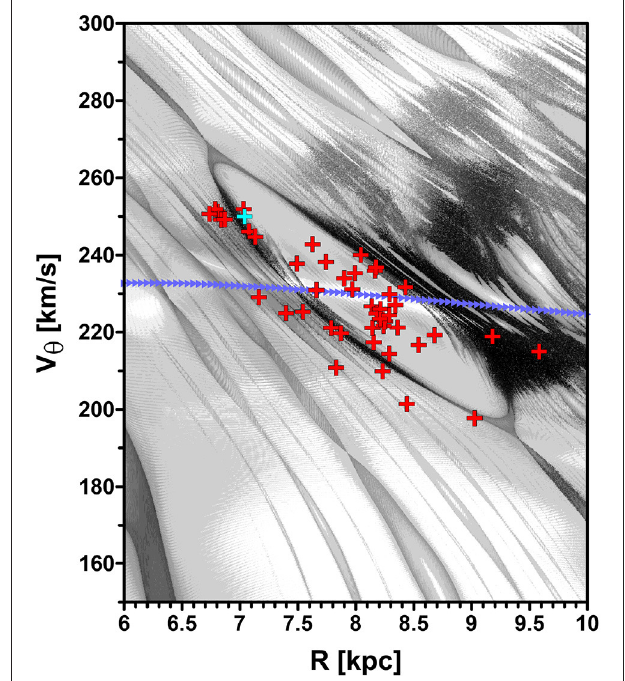
FIGURE 5 | Dynamical map on the R – V θ plane, as in Figure 3A , zoomed in the region of the local corotation zone. The central “oval” region represents the local corotation zone. The locations of maser sources associated with the Local Arm are shown by red crosses, while the blue cross shows one possible position of the Sun. The positions of the masers and the Sun on the map are obtained by propagating their current positions and velocities until each object crosses the representative plane, i.e., with the conditions p R = 0 and ϕ = 76 ◦ . The blue curve is the rotation curve of Equation